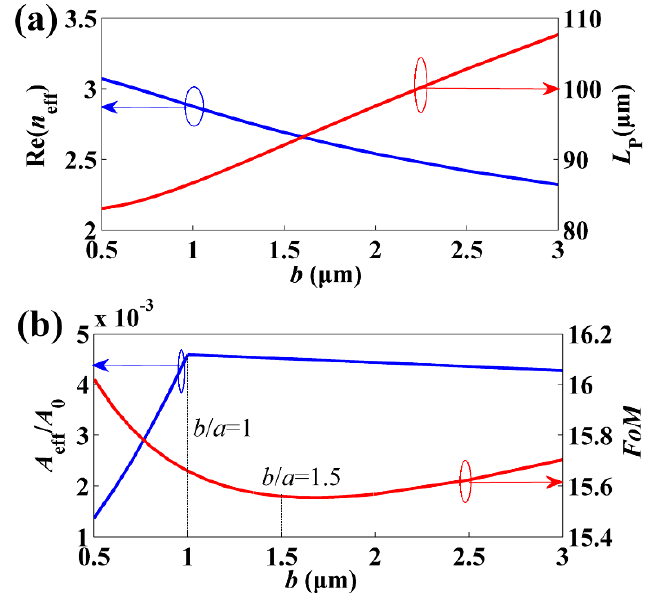
Figure 4. ( a ) Real part of n eff and L P , and ( b ) A eff / A 0 and FoM as a function of b at f 0 = 3 THz. Here u c = 0.5 eV, ε 1 = 2.25, ε 2 = 1, and a = 1 μm.